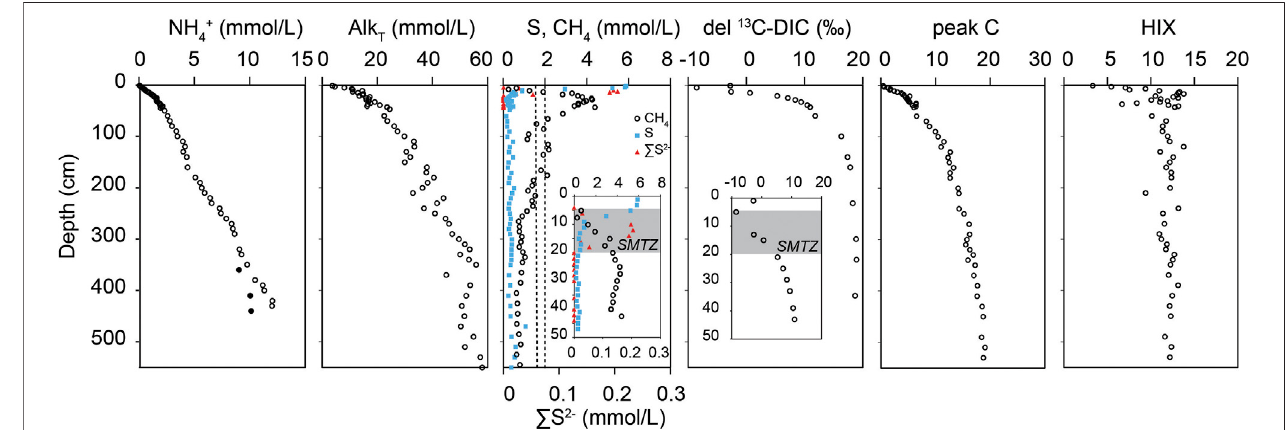
FIGURE4| Porewater pro fi les from theStorfjärden site. The fi gure combines datafrom multipleGEMAXand pistoncoresasdescribed in Table 1 .Inall cases, the uppermost 40 – 60 cm derive from GEMAX cores preserving the sediment-water interface. Inserts show expanded pro fi les through the SMTZ. Note that sulfur (S) is considered to represent SO 4 2 − (see text). Vertical dashed lines indicate saturation range of CH 4 at 1 atm pressure and 7.5 ‒ 15 ⁰ C (bottom water temperature and air temperature on deck). Peak C (cid:2) humic-like DOM fl uorescence; HIX (cid:2) DOM humi fi cation index.